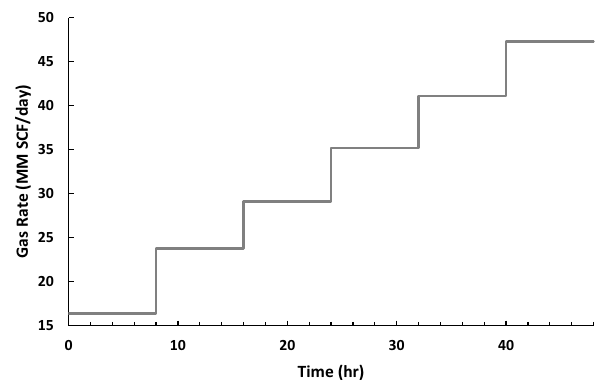
Fig. 4 Gas rate production vs. time in modified backpressure test at well #1